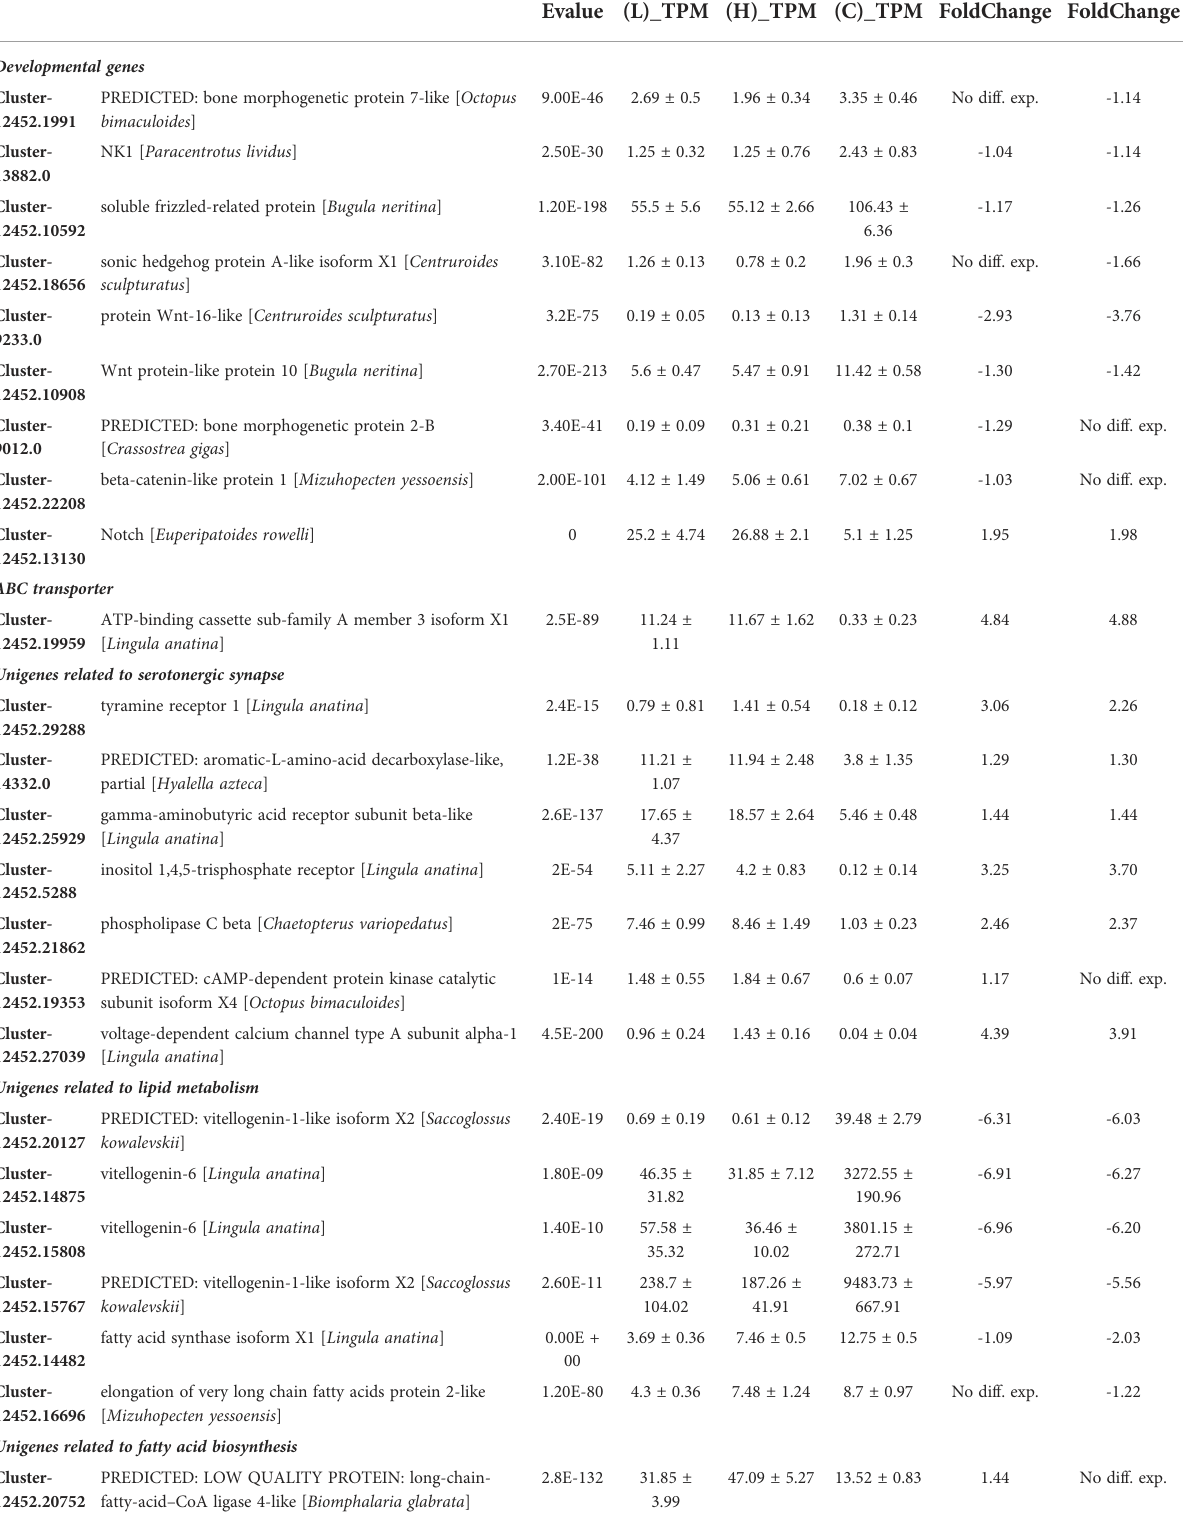
TABLE 1 Differentially expressed unigenes in [BU]-treated